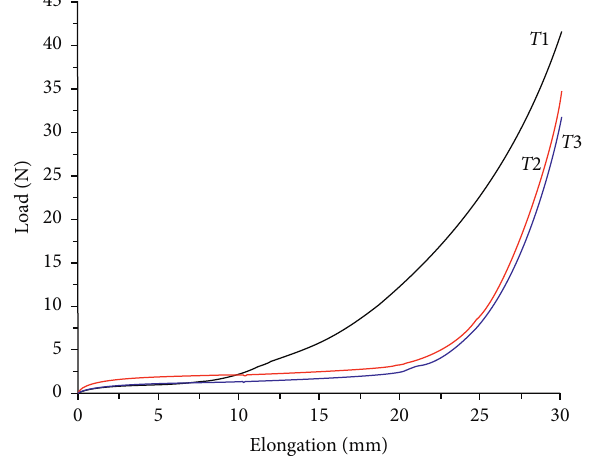
Figure 6: Load-elongation graph of the three tension tests of a porcine trachea